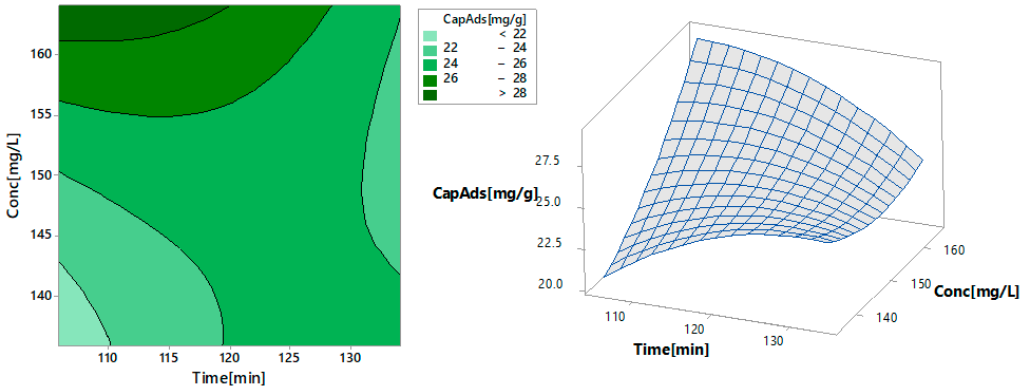
Figure 12. The contour ( left ) and surface ( right ) curves for the contact time and initial concentration if the response is the adsorption capacity.